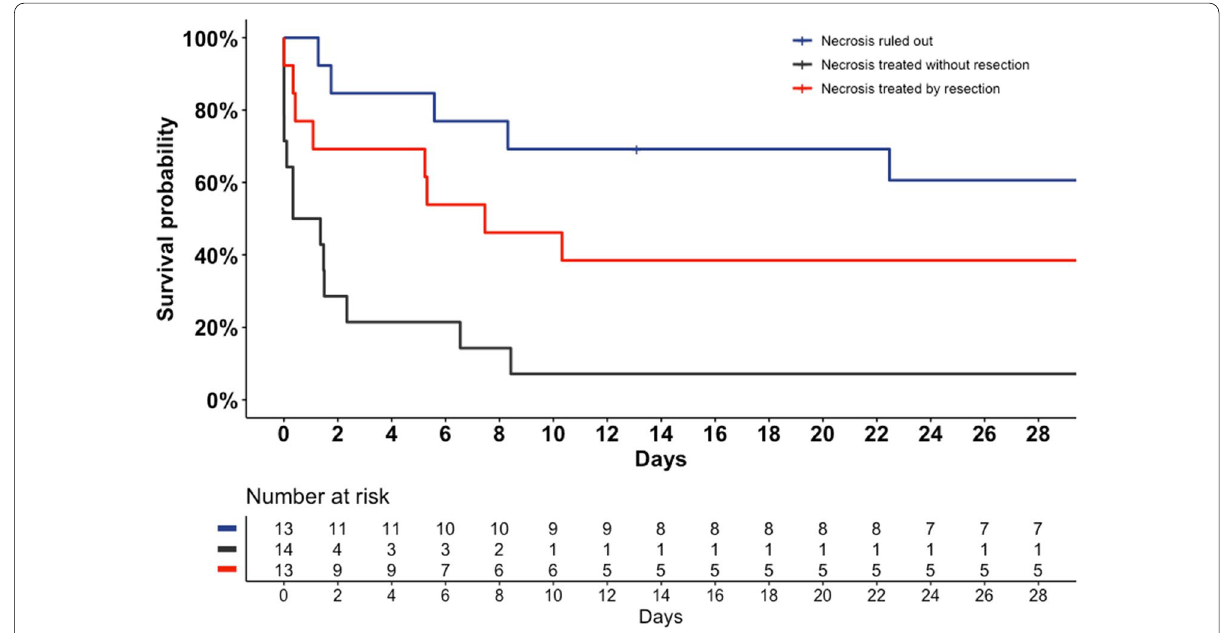
Fig. 3 Survival plot according to intestinal necrosis presence and necrosis